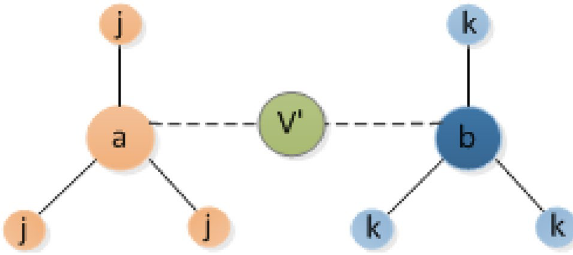
Figure 1. Virtual node action display